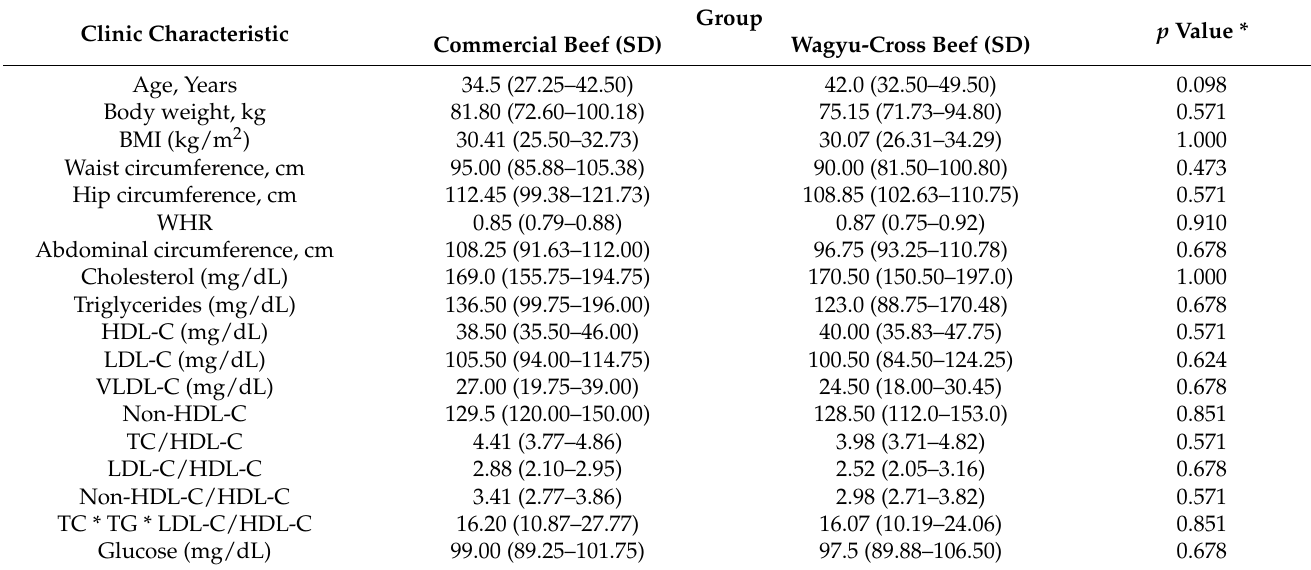
Table 1. Baseline anthropometric and biochemical characteristics of the volunteers 1 .